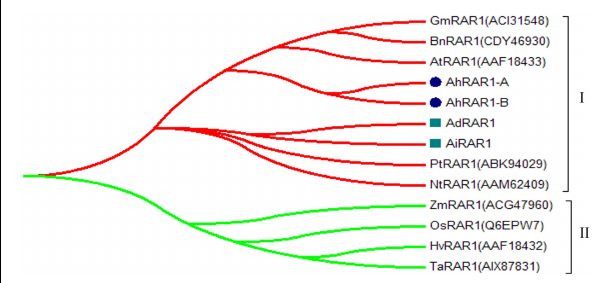
FIGURE 6 | Phylogenetic tree of RAR1 genes from Arachis , Arabidopsis , soybean, barley, common wheat, rice, maize, tobacco, rape, and Populus trichocarpa .